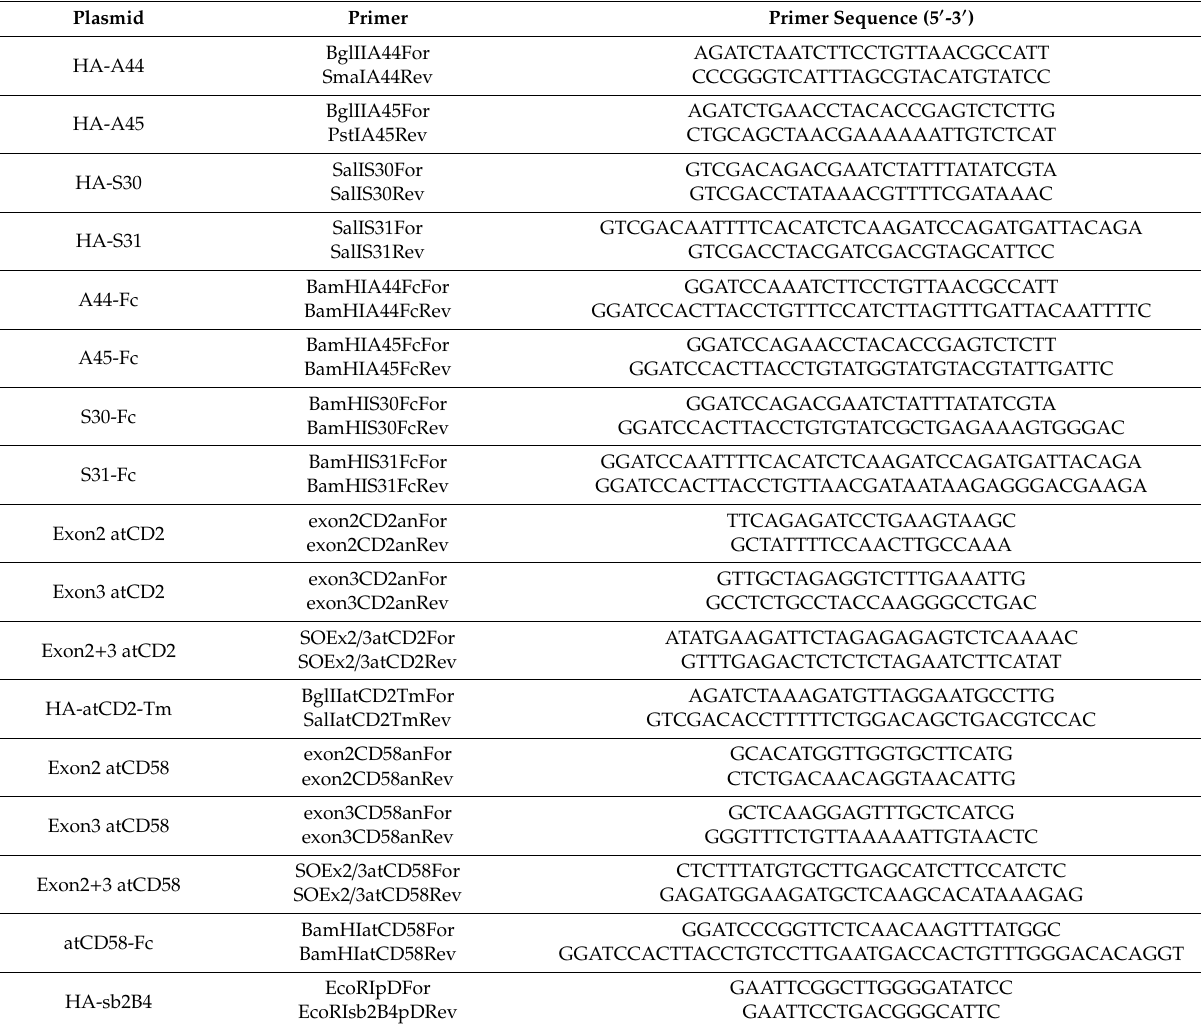
Table 1. Primer sets used in the